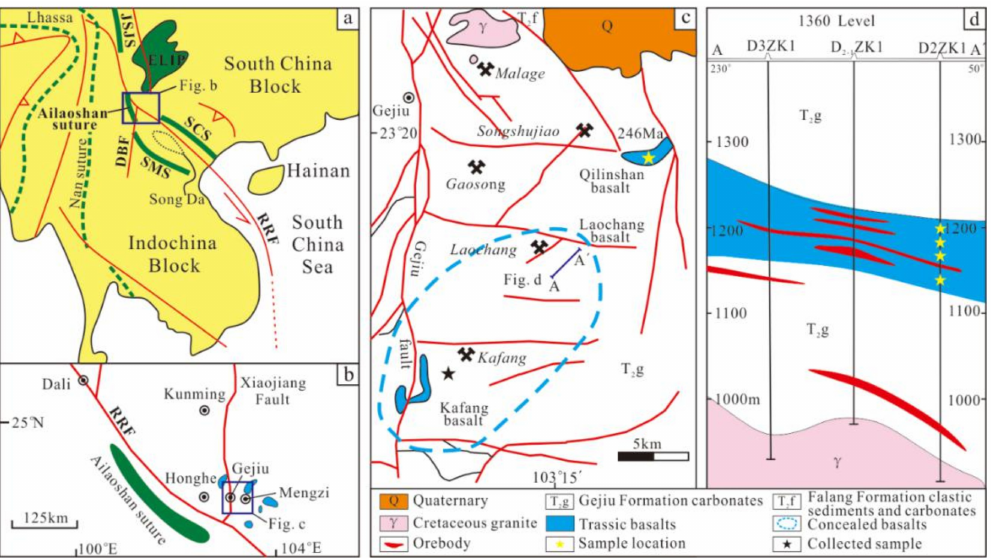
Figure 1. ( a ) Simplified tectonic map showing the study area in relation to major tectonic units in South China [23], JSJS: Jinshajiang suture, SCS: Song-Chay suture, SMS: Song Ma suture, RRF: Red River fault, DBF: Dien Bien Phu fault; ( b ) Simplified map showing the location of the study area [27]; ( c ) Geological map of the Gejiu ore district [21]; ( d ) Geological section of basalts in Laochang ore